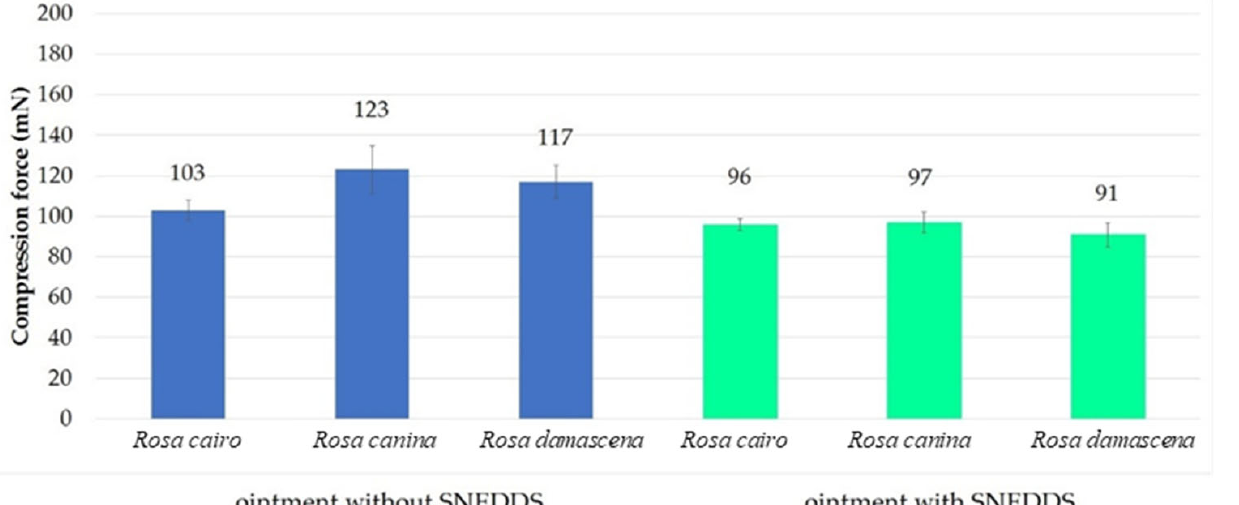
Figure 4. Diffusion profile of formulations without SNEDDS. T he maximum amount of diffused quercetin reached 19.54% after 60 minutes, remaining at the same value after 90 minutes.